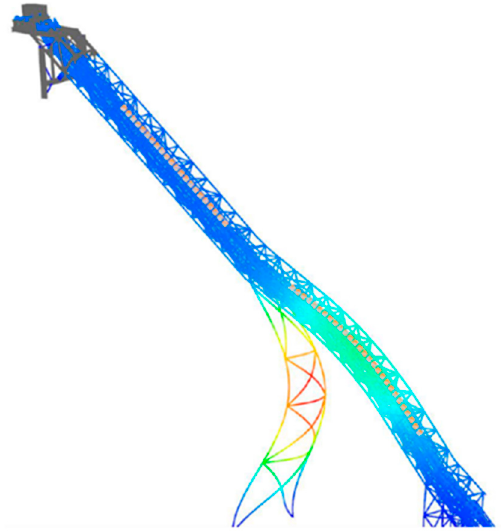
Figure 20. The 2.9 Hz vibration mode of the structure.